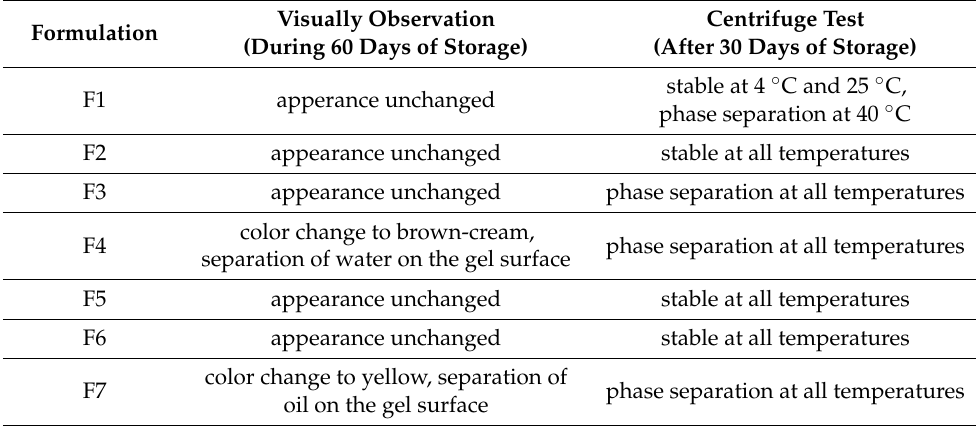
Table 2. Visual observation and centrifuge test during stability evaluation.